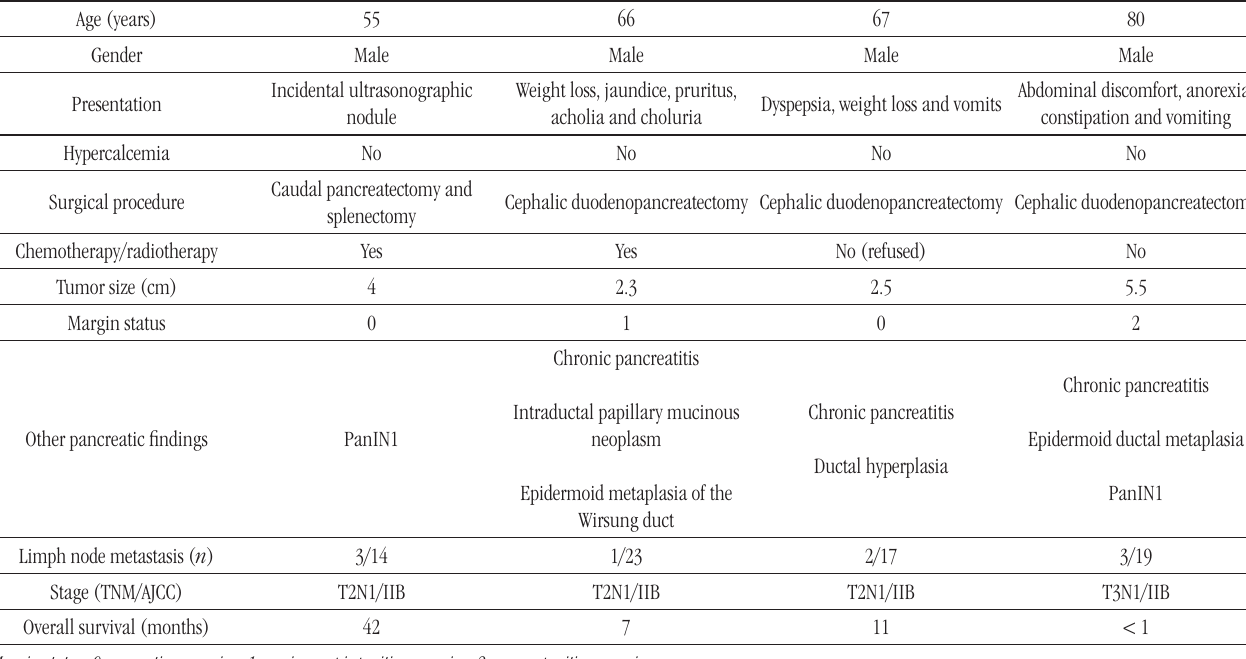
taBLE − Clinical and pathological characteristics of the four